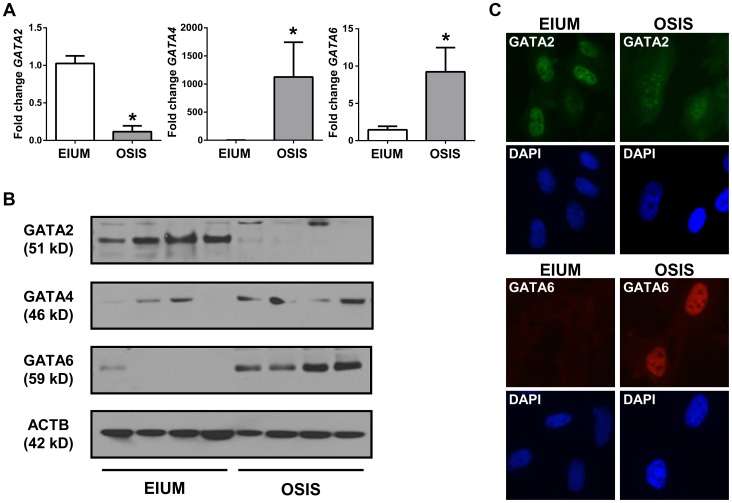
GATA isoform expression in stromal cells.The expression of GATA2, GATA4, and GATA6 in EIUM and OSIS is shown using (A) qPCR (asterisks indicate p<0.05, t-test, n = 6), (B) immunoblot for 4 EIUM and 4 OSIS samples, (C) immunofluorescence for GATA2 (pseudocolored green; top panels) and GATA6 (red; bottom panels) in EIUM (left column) and OSIS (right panel), using DAPI as a nuclear counterstain.